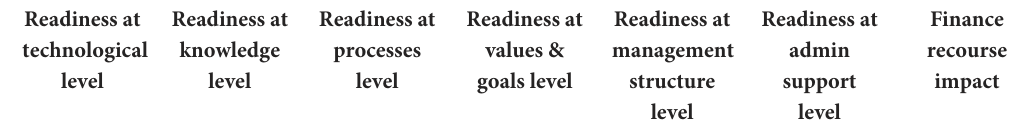
TABLE 5 Spearman’s rho correlation coefficient between the 10